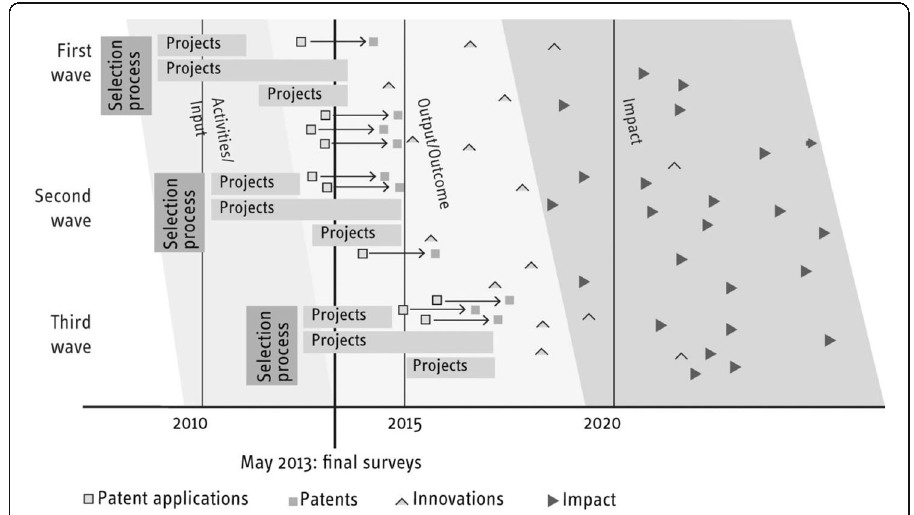
Fig. 4 Timeline and objectives of the Leading-Edge Cluster Competition and the funded projects. Source: Accompanying evaluation of the